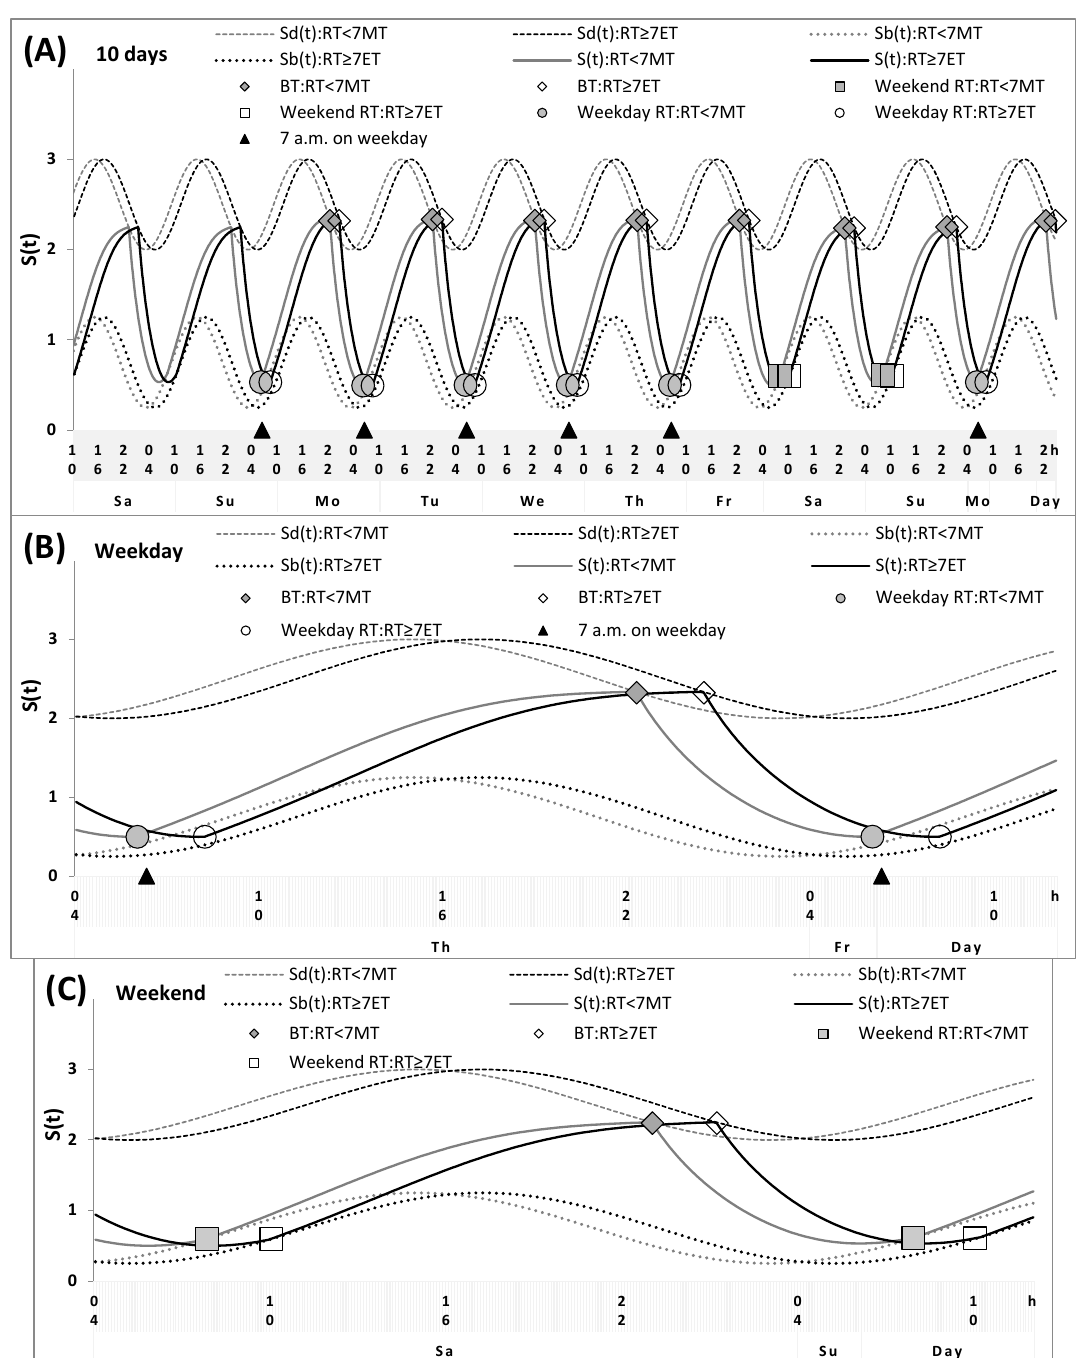
Figure 3. Simulations of the sleep–wake cycles of early morning types and late evening types. Simulations of the whole sequence of 10 sleep–wake cycles ( A ), and two subintervals for a weekday and a weekend, ( B , C ), respectively, for the participants with different chronotypes and risetimes (RTs), MT with early RT and ET with late RT (RT <7 MT and RT ≥ 7 ET, respectively. See Table 3 and Figure 4 (right graphs) for the comparison of these simulations with sleep times self-reported by lecturers. The simulations suggested that, in general, the parameters of the sleep–wake regulatory processes may be practically identical in these two subdivisions. The only postulated difference was the difference in sleep times on free days, whereas the advances in weekday waking times were suggested to become equal in these MTs and ETs due to the early weekday RT of the former and the late weekday RT of the latter (2.0 h). Therefore, the difference in the circadian phase (2.2 h) was the only contributor to the difference between these subdivisions of MT and ET in sleep